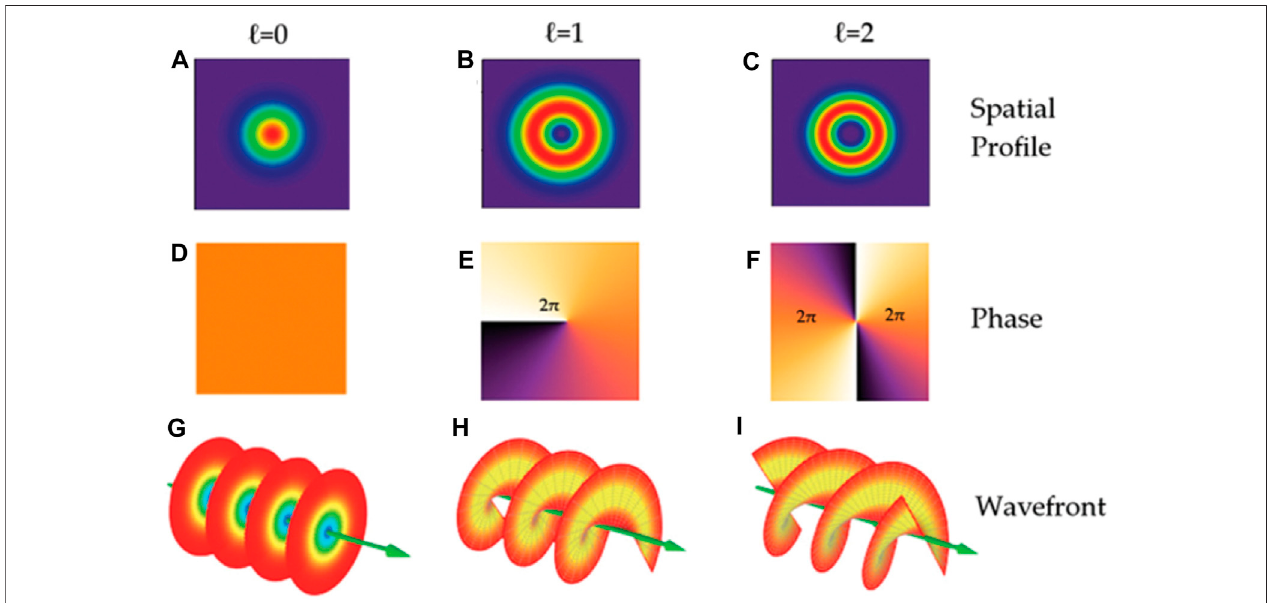
FIGURE 3 | The spatial phase structure of plane waves and vortices with different topological charges. The differences between the Gaussian beam and vortex beam are shown in spatial pro fi le (A – C) , phase (D – F) , and wavefront (G – I) . Reproduced from Intech [46].